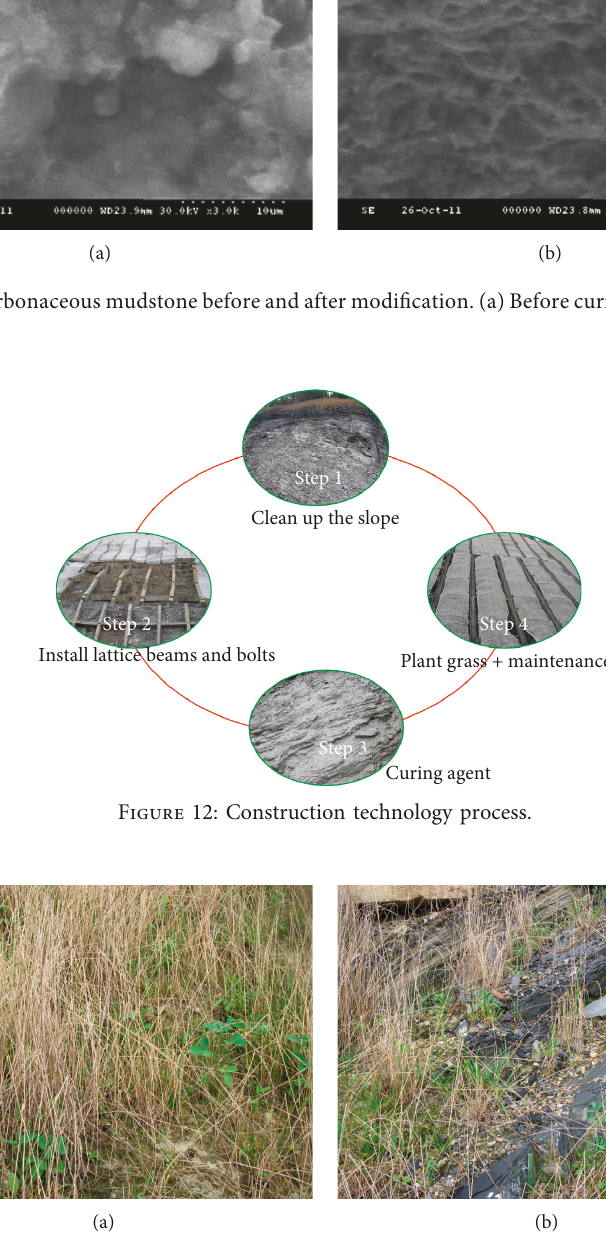
Figure 13: The effect of slope protection under different conditions. (a) Cured slope. (b) Slope without